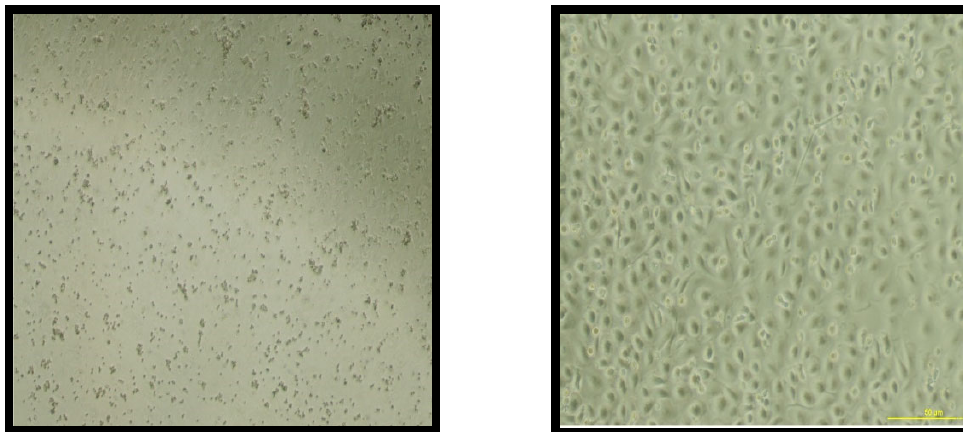
Figure 4. Morphological microscopic appearance of monocytes and macrophages. The figure on the left represents the shape of the isolated monocyte cells under the light microscope (×10) at day 1 immediately after magnetic separation. The figure on the right shows the monocyte ‐ derived macrophages under the microscope (×10) after 7 days of monocyte culturing in the presence of GM ‐ CSF. GM ‐ CSF, granulocyte ‐ macrophage colony stimulating factor.